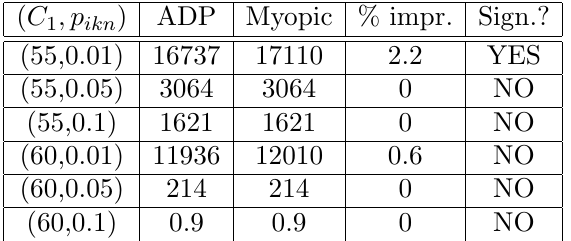
Table 3. Results for the rigid toler- ance case with N = 20.